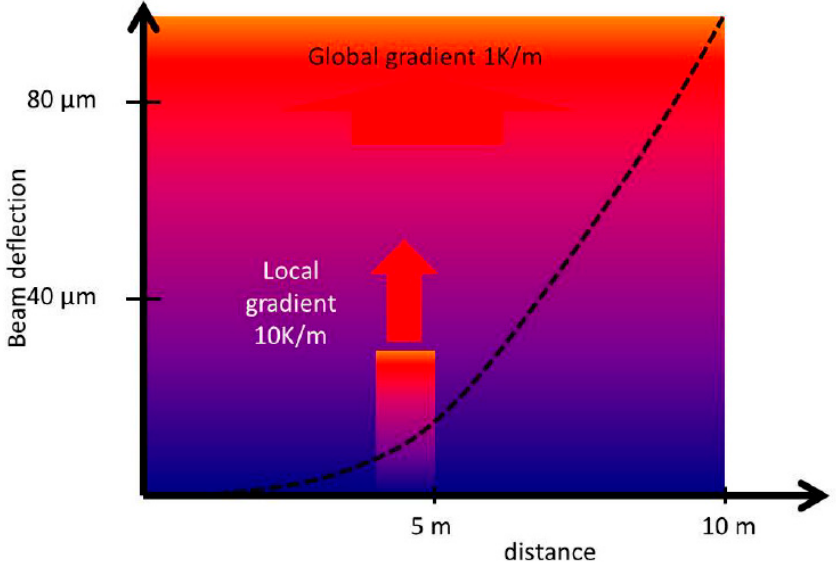
Figure 7. Bending of a straightness reference beam due to local and global gradients [72].